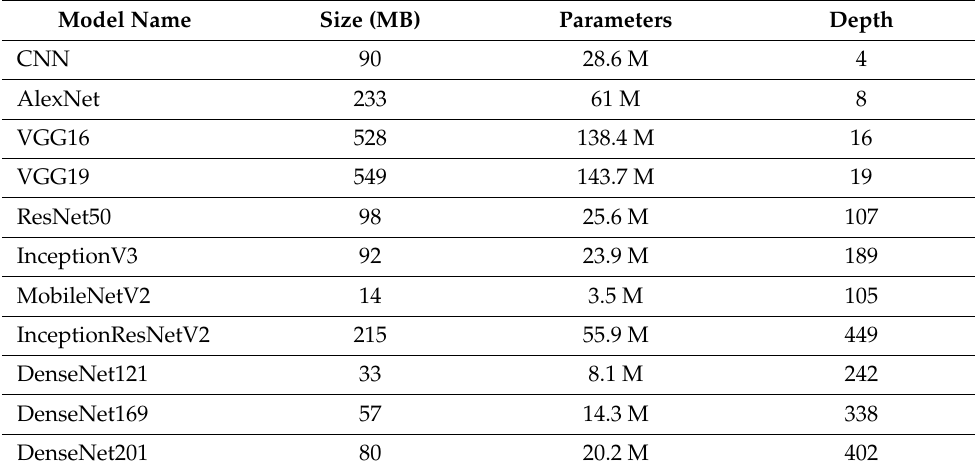
Table 2. Basic deep learning models and their